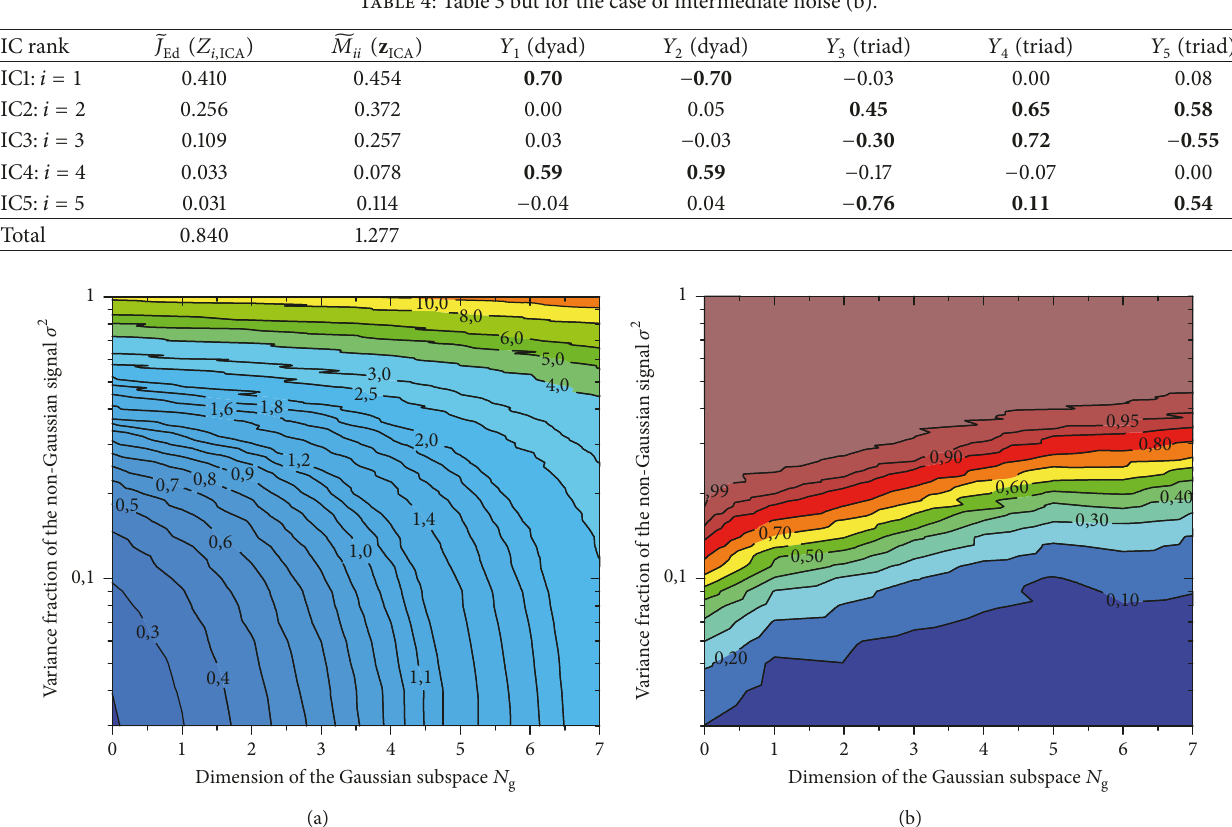
Figure 7: (a) Monte-Carlo average of the sample negentropy estimator of times for which the null hypothesis 𝐻 𝐺 is rejected at 𝑝 can mark 𝜎 2 at the 99% confidence min